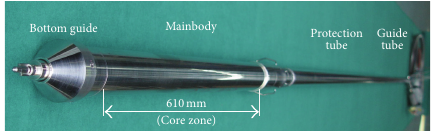
Figure 1: Instrumented capsule for the material irradiation test.